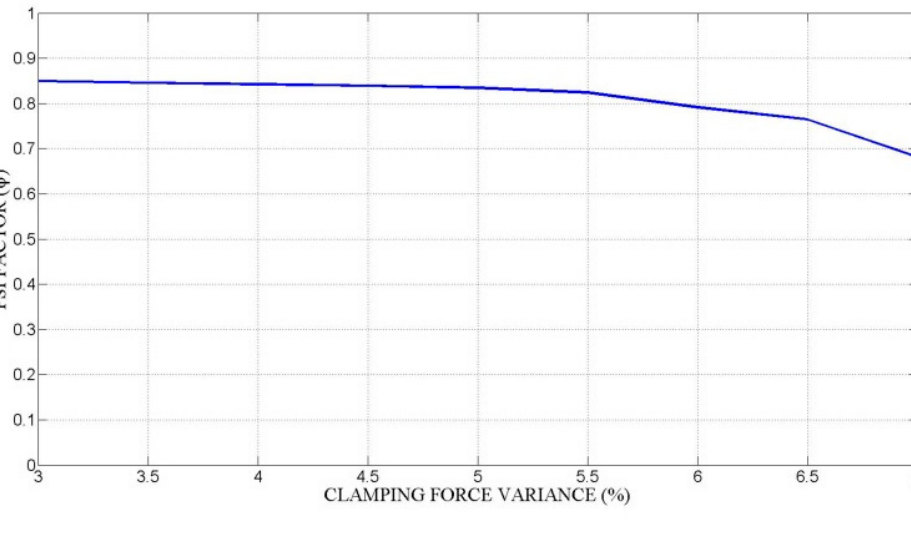
Figure 20. Expanding mandrel prototype within the air sensing system. 5.4. Stress throughout contact between cone and collet A dimensionless parameter t is defined according to Equation (30) for a better comprehension of the analysis results, where La is the cone length in contact with the collet at any time, and L b is the total length of the collet. Obviously, 0 ≤ t ≤ 1. a b L L τ =